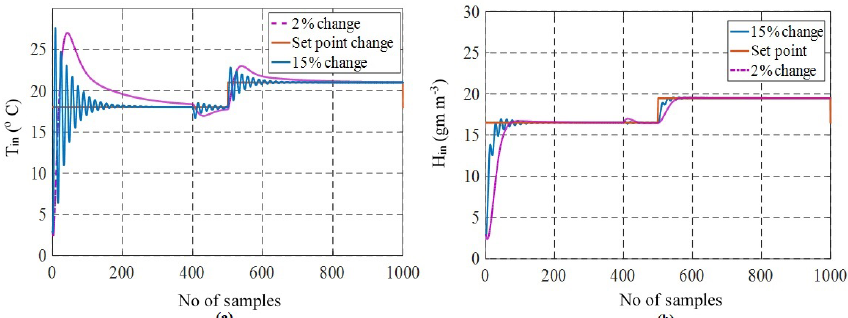
Figure 18. (a) Graphical Representation of 2% and 15% Changes in Inlet Temperature T in and (b) Graphical Representation of 2% and 15% Changes in Inlet Humidity H in .